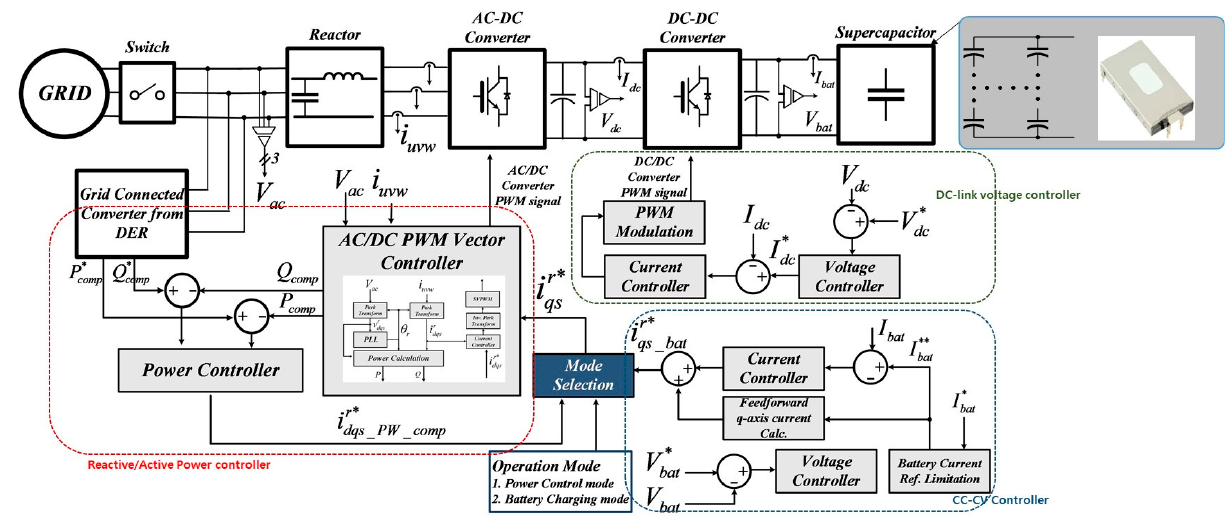
Figure 13. Algorithm block diagram for power compensator control.